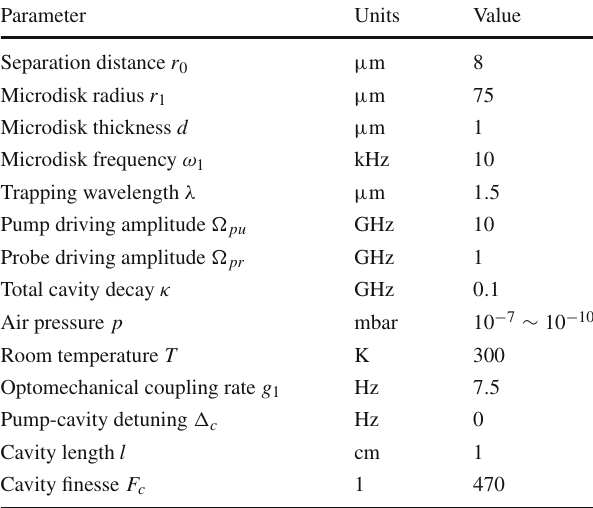
Fig. 5 Limit on the compactification range R ∗ and the extra dimen- sions induced coupling β with the ADD formalism. The parameters take the same values as in Table